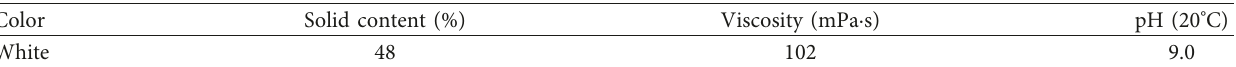
Table 5: Properties of the acrylic emulsion.